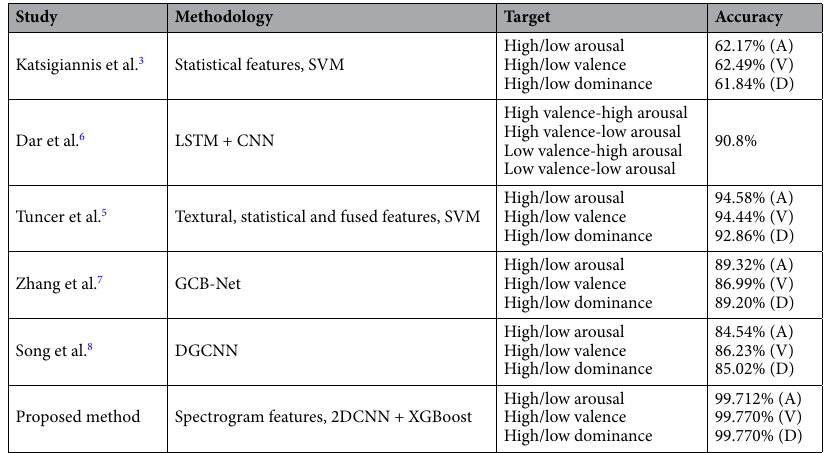
Table 1. Comparison with state-of-the-art related work on DREAMER dataset. A, V and D represent arousal, valence and dominance